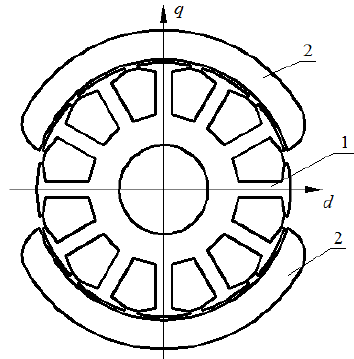
Fig. 2. Construction scheme of new design SynRM with segment-shaped outer rotor.